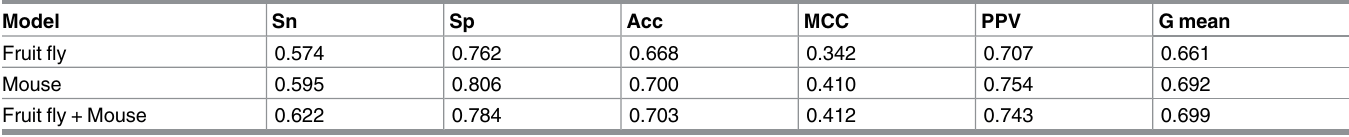
Human A-to-I RNA editing events can be predicted from animal models Next, we employed one-class classification models built on fruit fly and mouse data to study A- to-I RNA editing events in humans (Table 2). With a small nu, the model trained on fruit fly data was more efficient in correctly predicting A-to-I RNA editing events in human data than the corresponding model trained on mouse data. However, the model derived from fruit fly data also incorrectly assigned a large number of negative instances as editing events. As shown in Table 3, the binary classification gave reasonable results for all species, correctly recognizing 80% of the negative instances. The model trained on mouse data outperformed the model trained on fruit fly data (2.1%, 6.8% and 4.7% improvement in Sn, MCC, and PPV, respec- tively) in predicting A-to-I RNA editing events in the human data. Due to the differences between models trained on the different species, we trained a model on combined fruit fly and mouse data. With this mixed-model, prediction of editing events in human data was improved with respect to sensitivity (yielding an Sn of 0.622, MCC of 0.412 and G mean of 0.699). Remarkably, the PPV values were above 0.700 in all three animal mod- els, indicating a low false discovery rate. Hence, models generated on fruit fly and mouse data reliably recognizedhuman editing events. Table 3. Predicting RNA editing events in human using animal models. Model Sn Sp Acc MCC PPV G mean Fruit